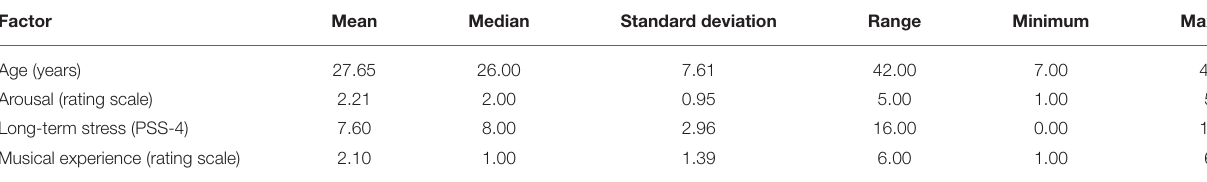
TABLE 1 | Descriptive statistics of fixed factors.